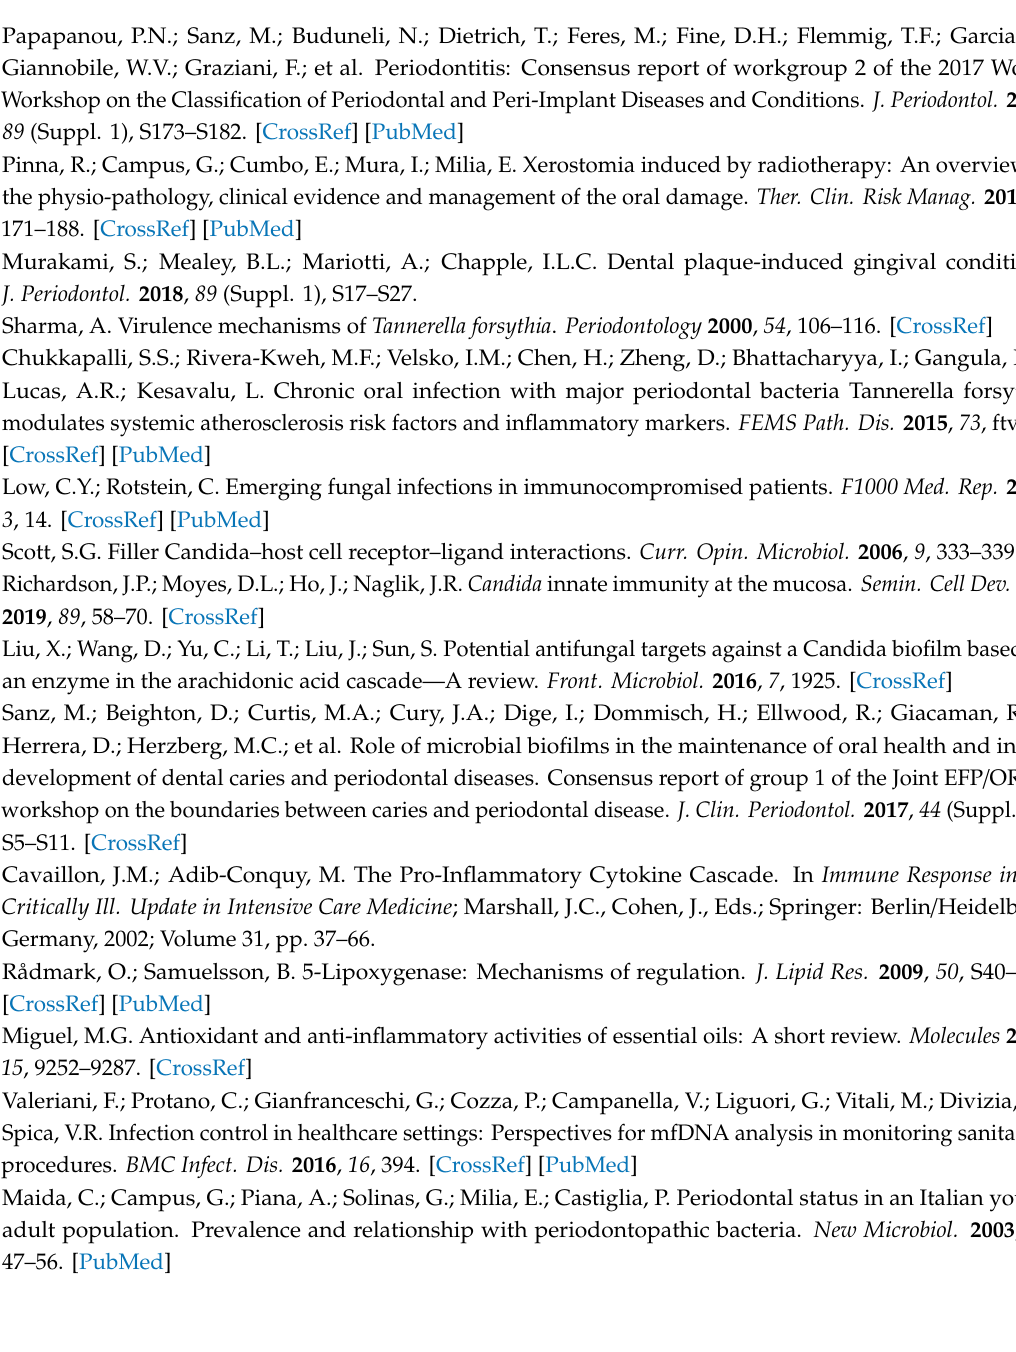
Figure S1: Cyclic voltammetry of α -pinene, Figure S2: Cyclic voltammetry of terpinen-4-ol, Figure S3: Cyclic voltammetry of α